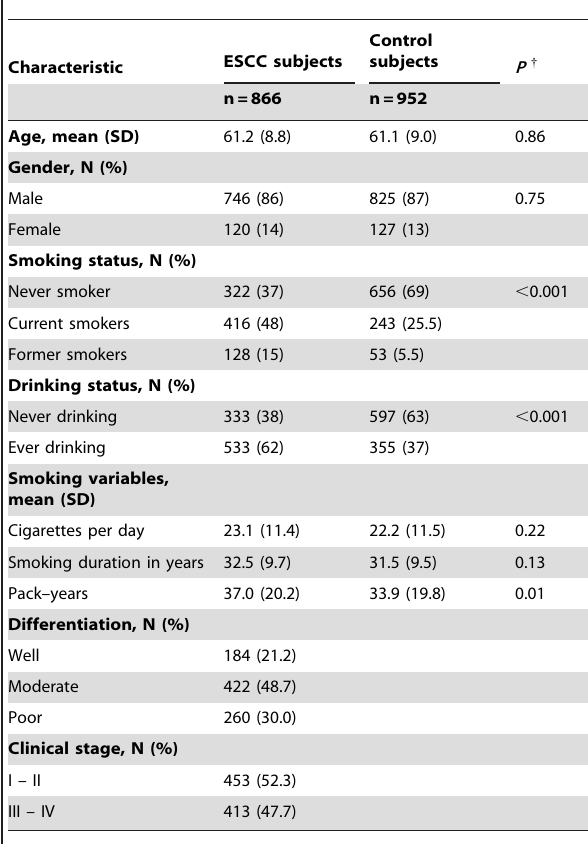
Table 3. Stratification analysis of rs667282 genotypes by selected variables in ESCC patients and